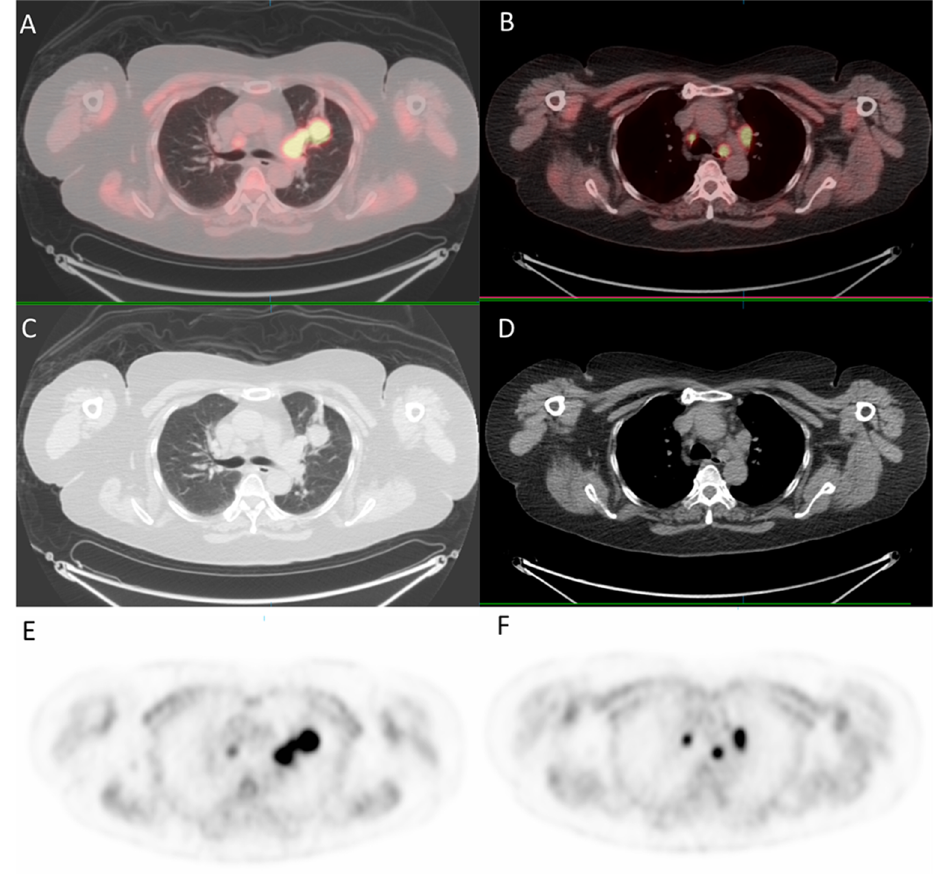
Figure 5. 18 F-fludeoxyglucose positron emission tomography/computed tomography ( 18 F-FDG PET/CT) for whole-body evaluation. ( A , B ) axial fused PET/CT showing focal uptake of the lung and mediastinum, respectively; ( C , D ) axial CT; ( E , F )